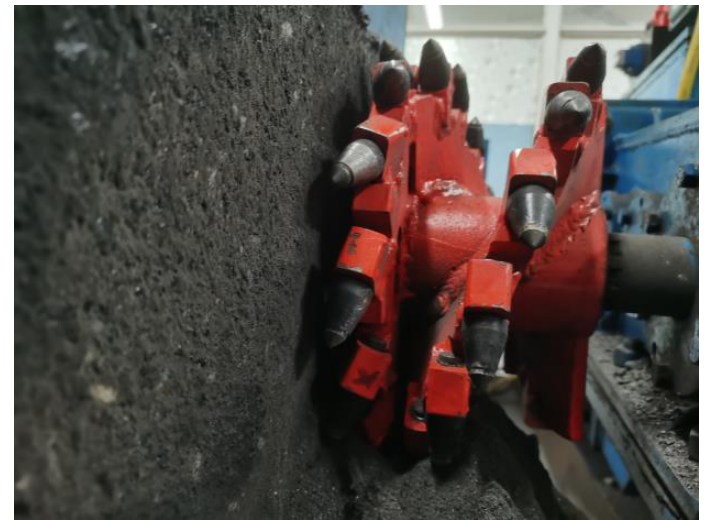
Figure 10. Cutting effect diagram.